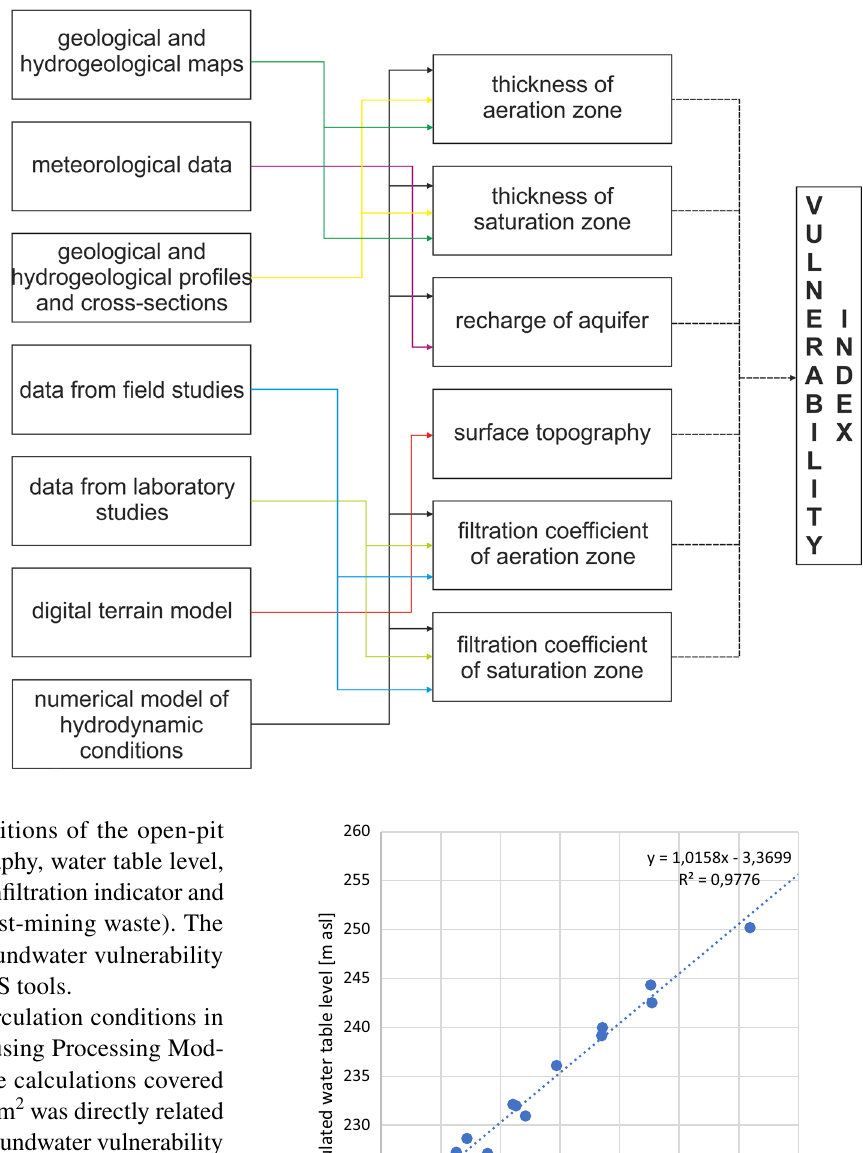
Fig. 3 Flowchart of the meth- odology